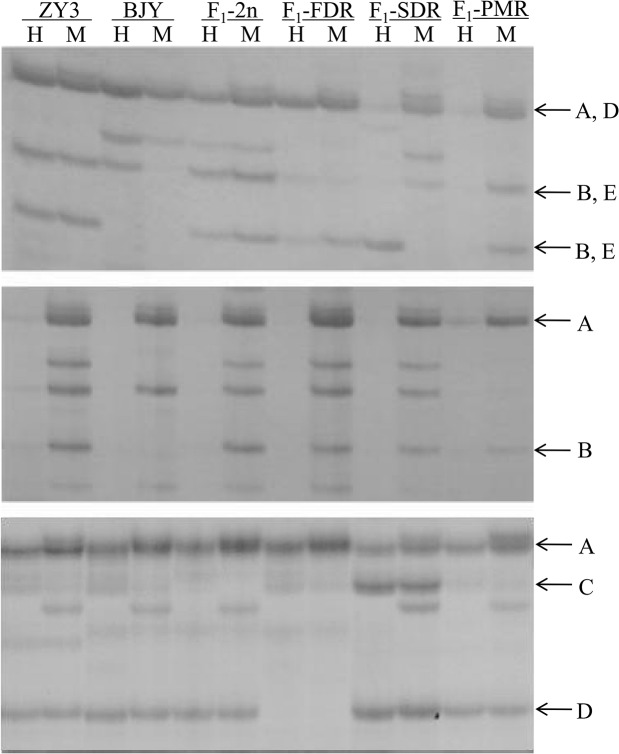
Examples of MSAP profiles showing the inheritance and variation of DNA methylation sites in F1 hybrids relative to their parental lines.H genomic DNA was digested with HpaII and EcoRI; M genomic DNA was digested with MspI and EcoRI; Primer combinations are E00+GC/ HM00+CT (a), E00+CC/HM00+TC (b), E00+GG/ HM00+TG (c). (A) Monomorphic inheritance; (B) Additivity inheritance; (C) Demethylated; (D) Hyper- methylated; (E) Unidentified types.